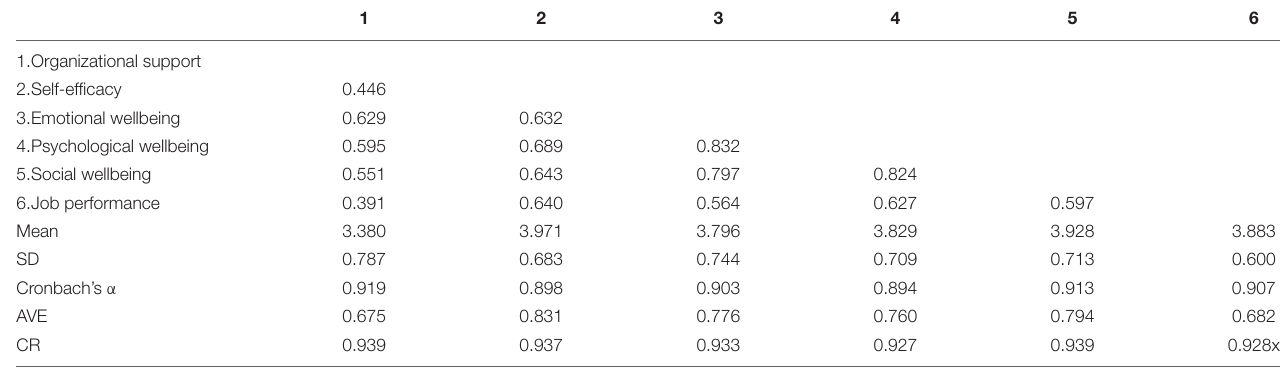
TABLE 2 | Measurement model.